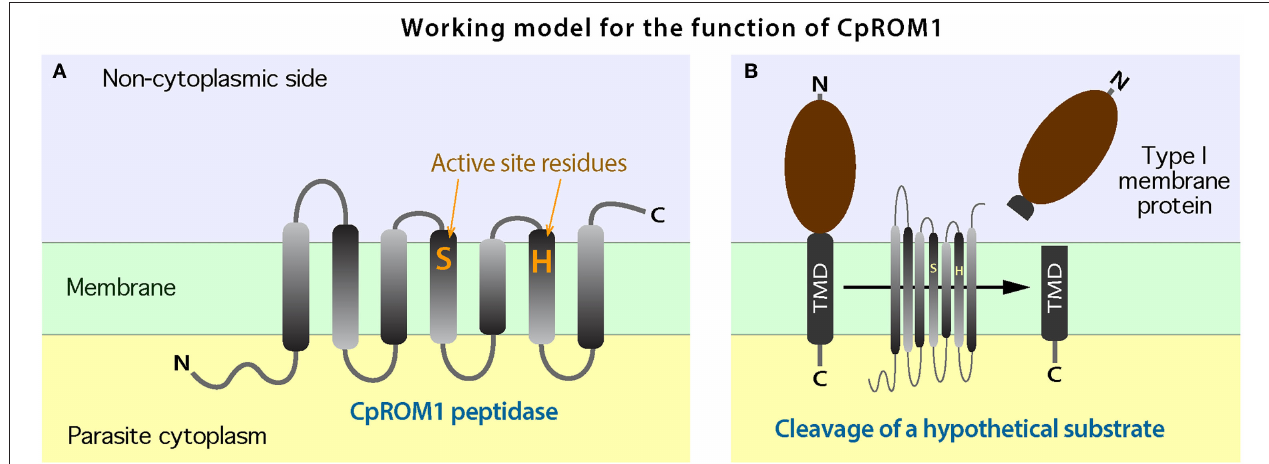
FIGURE 10 | A working model for the biochemical function of CpROM1. (A) Arrangement of the seven transmembrane domains (TMDs) of CpROM1 across the plasma membrane. Parasite cytoplasmic and non-cytoplasmic sides are shown below and above the membrane. The two active residues at the active sites in TMD4 and TMD6 are located close to the non-cytoplasmic side. (B) Illustration of the CpROM1-mediated intramembrane cleavage of a hypothetical type I membrane protein with a single TMD at the C-terminus. After cleavage, the functional section of the substrate protein is released into the non-cytoplasmic side.